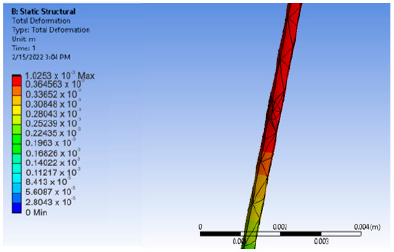
Figure 23. Displacement map for z = 10 mm and force F = 0.1 N.